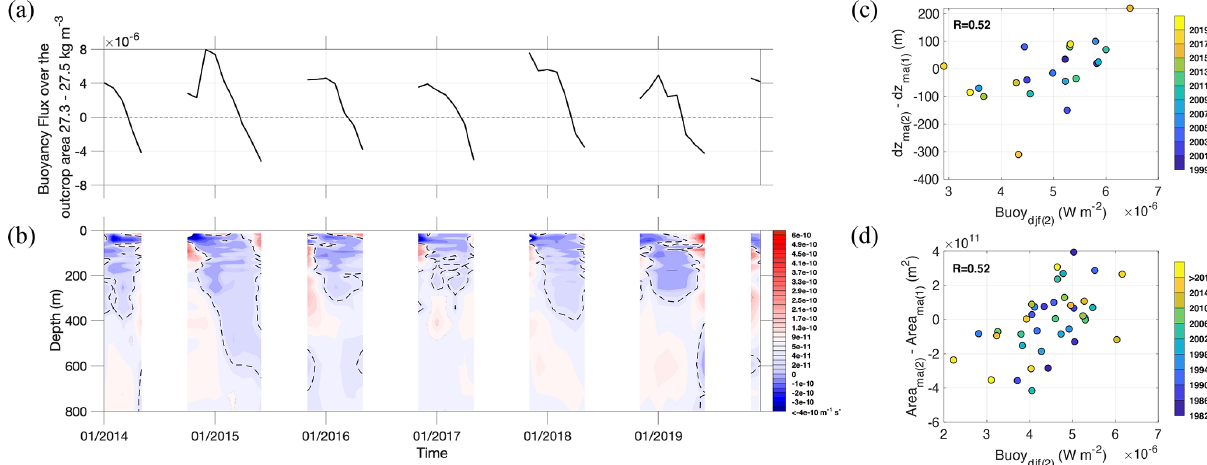
Figure 2. (a) Buoyancy flux (Wm − 2 ) and (b) potential vorticity (m − 1 s − 1 ) averaged over the source density area in the Iceland Basin. Positive buoyancy flux leads to a densification of the surface water (term in square brackets in Eq. 1). The isopycnals 27.3 and 27.5kgm − 3 do not outcrop over the Iceland Basin during summer. The dashed black line shows the potential vorticity 4 × 10 − 11 m − 1 s − 1 . (c) Correlations between the buoyancy flux averaged over December–January–February in the second winter (Buoy djf ( 2 ) ) and the difference in SPMW thickness March–April between the end of the first (dz ma ( 1 ) ) and second (dz ma ( 2 ) ) winters over 1999–2019. The SPMW thickness was estimated by the depth of the potential vorticity isoline 4 × 10 − 11 m − 1 s − 1 over the source water area (as shown in Fig. 2b). EN4.2.1 data before 1999 are not used because of large uncertainties due to scarce observations at depth. (d) Correlation between the buoyancy flux averaged over December–January–February in the second winter (Buoy djf ( 2 ) ) and the difference in surface area between the end of the first (area ma ( 1 ) ) and second winters (area ma ( 2 ) ). All correlations have p values <